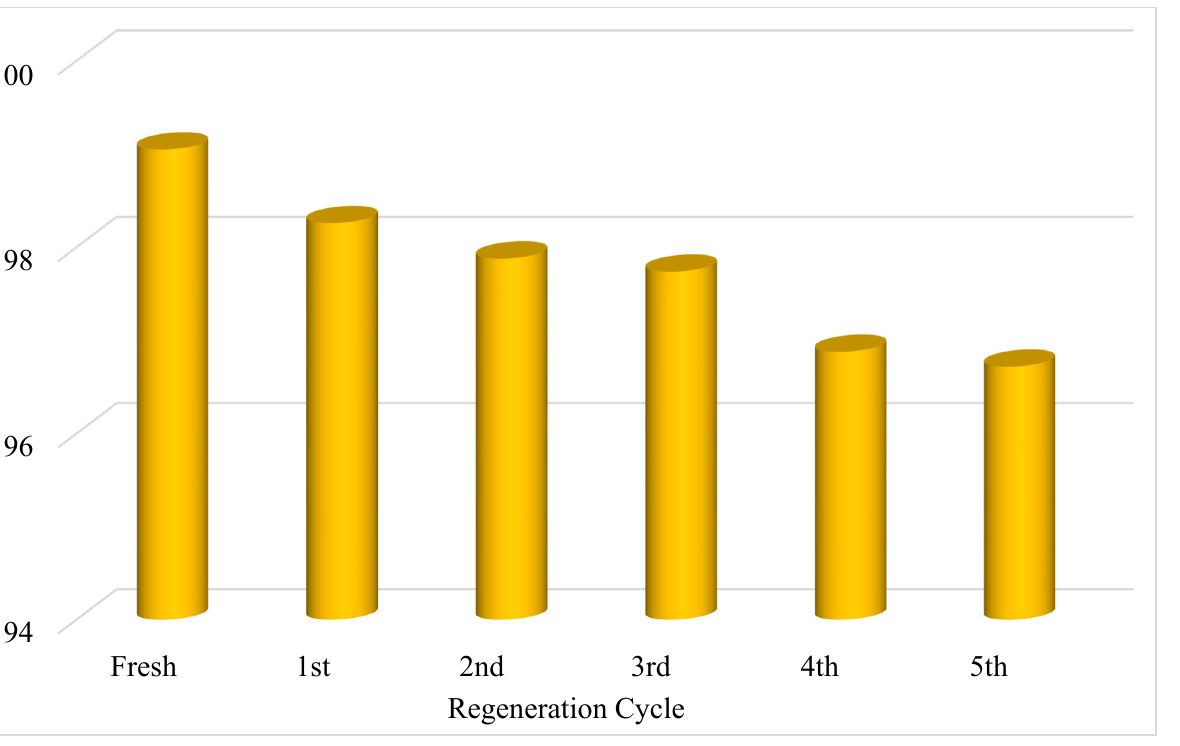
Figure 7. Reuse of PbO@MgZnO for the MD dye.